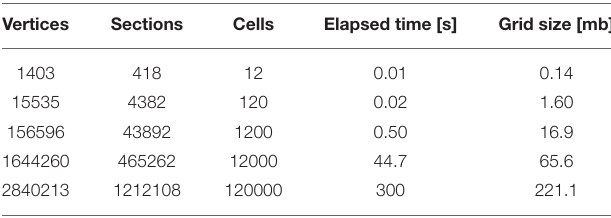
The networks are composed of L5A and L5B pyramidal cells ( 16% each), of L4 spiny ≈ stellate cells ( 42%) as well as L2/3 pyramidal neurons ( 26%). The smallest network ≈ ≈ contains 12 and the largest network 120,000 cells in total. To create even larger networks with the same memory resources, one can decrease the number of compartments using the section_length